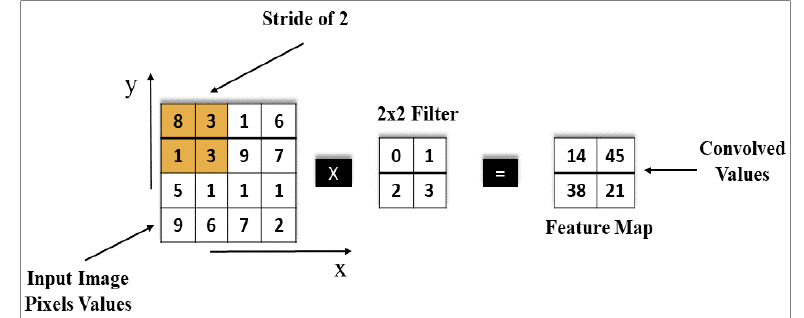
Fig. 2. Convolution operation.